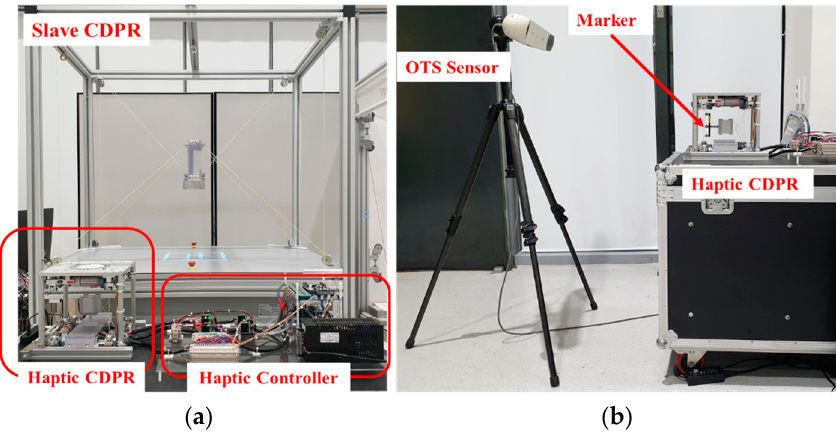
Figure 7. Experimental setup: ( a ) experimental setup for evaluating the positional accuracy of the master device; ( b ) experimental setup for evaluating the applied admittance control algorithm and the teleoperation system.